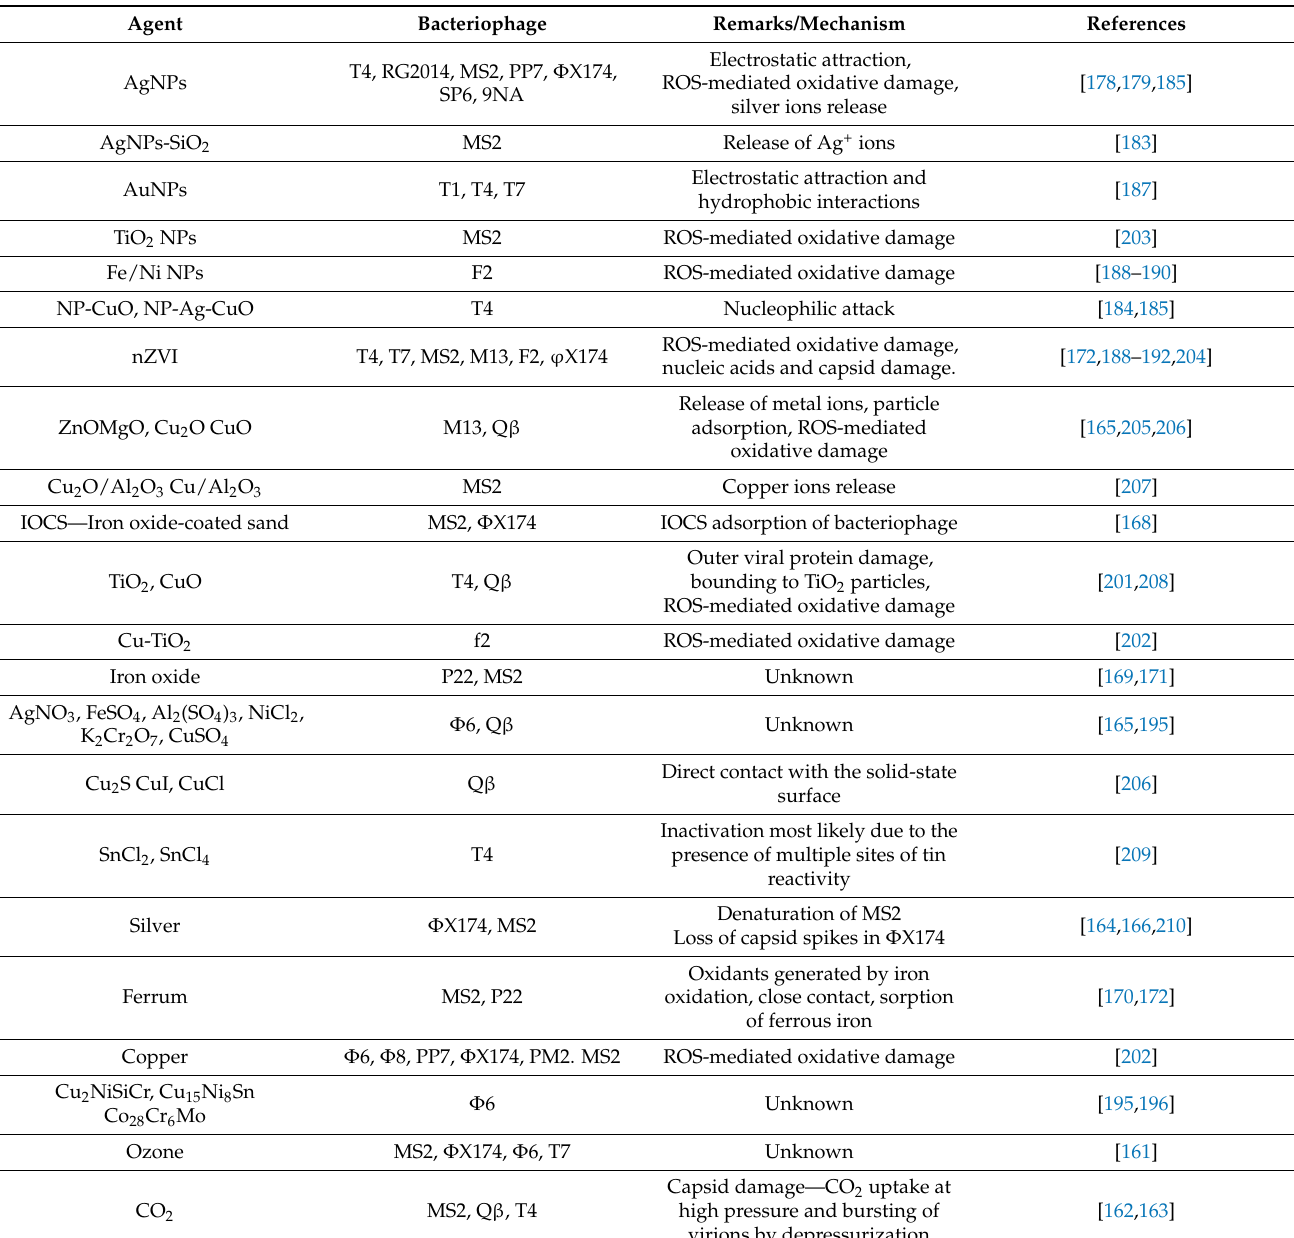
Table 3. Methods of bacteriophages disinfection based on inorganic